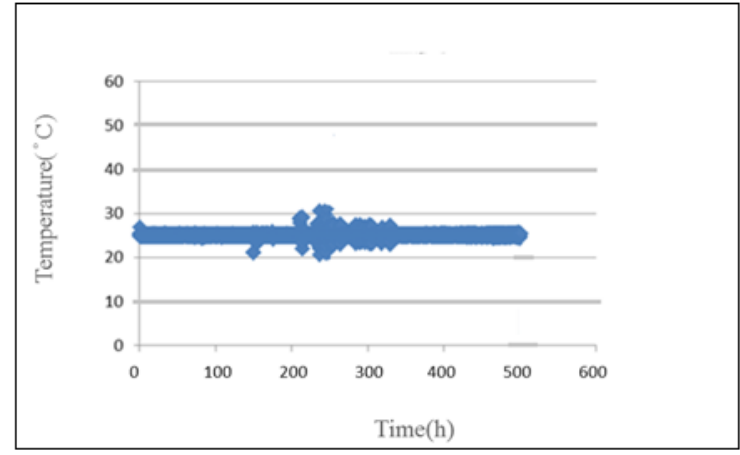
Figure 18. Curve of temperature inside PEM water electrolyzer. As the PEM water electrolyzer shall be tested in pure water, the relative humidity is very close to 100%, as shown in Figure 19.